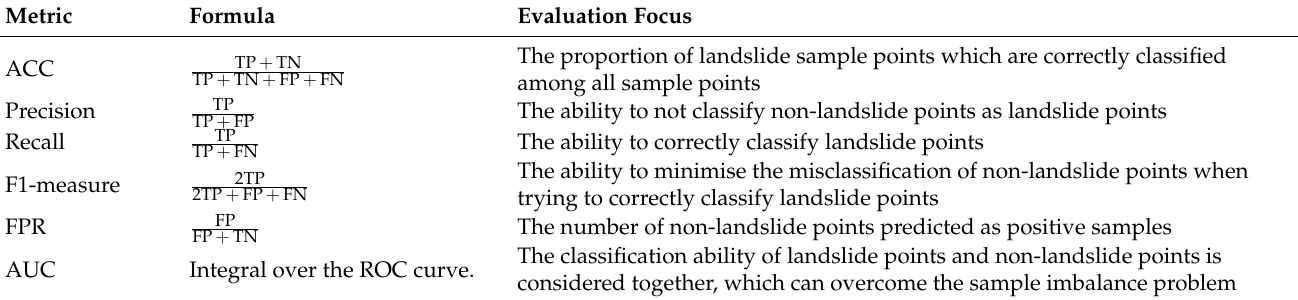
Table 2. Performance evaluation metrics used to assess the binary machine learning